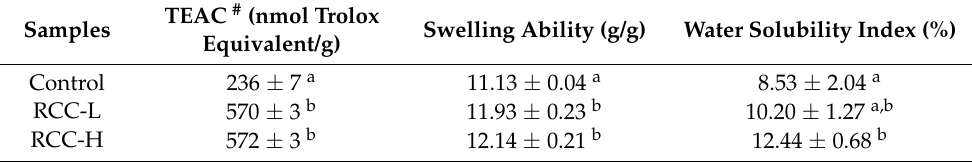
Table 2. Antioxidant activity, swelling ability, and water solubility index among different rice samples. TEAC # (nmol Trolox Samples Equivalent/g)